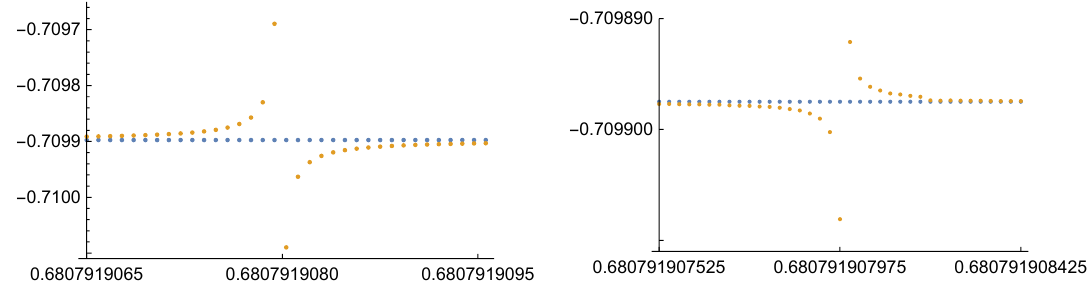
Figure 18. Gauge theory 2-particle Baxter solution q ( (cid:27) ) for ! 1 = 1 p a = 0 : 87 (value not satisfying the quantization conditions).